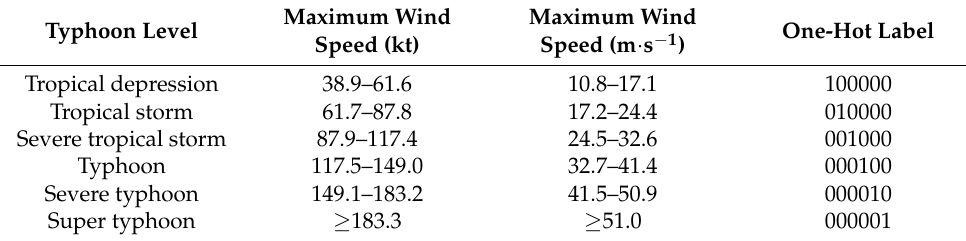
Table 1. Typhoon intensity standard level and one-hot